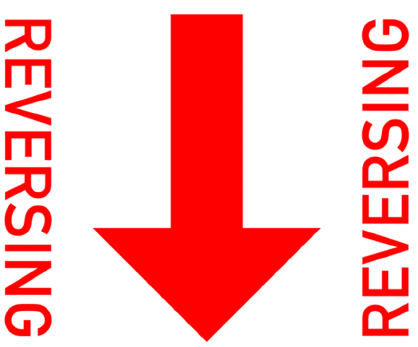
Figure 5. Projected graphic representing “Pedestrian Instruction”, hereafter referred to as “Stop Signs”.